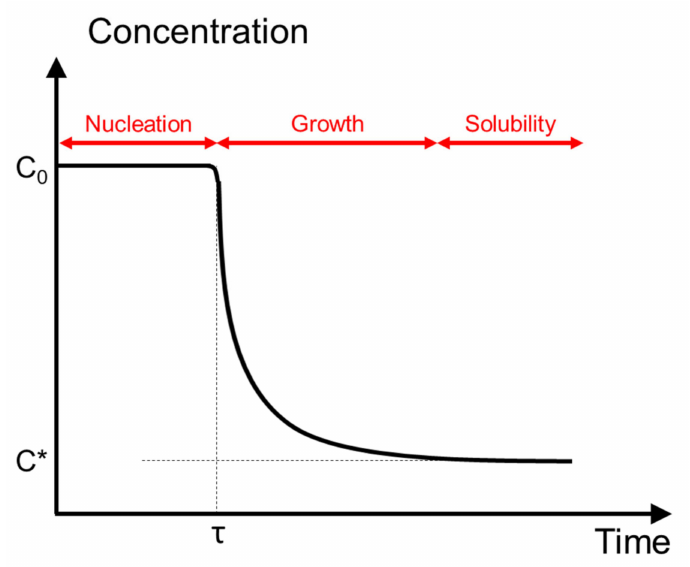
Figure 3. Desupersaturation curve of crystallization in